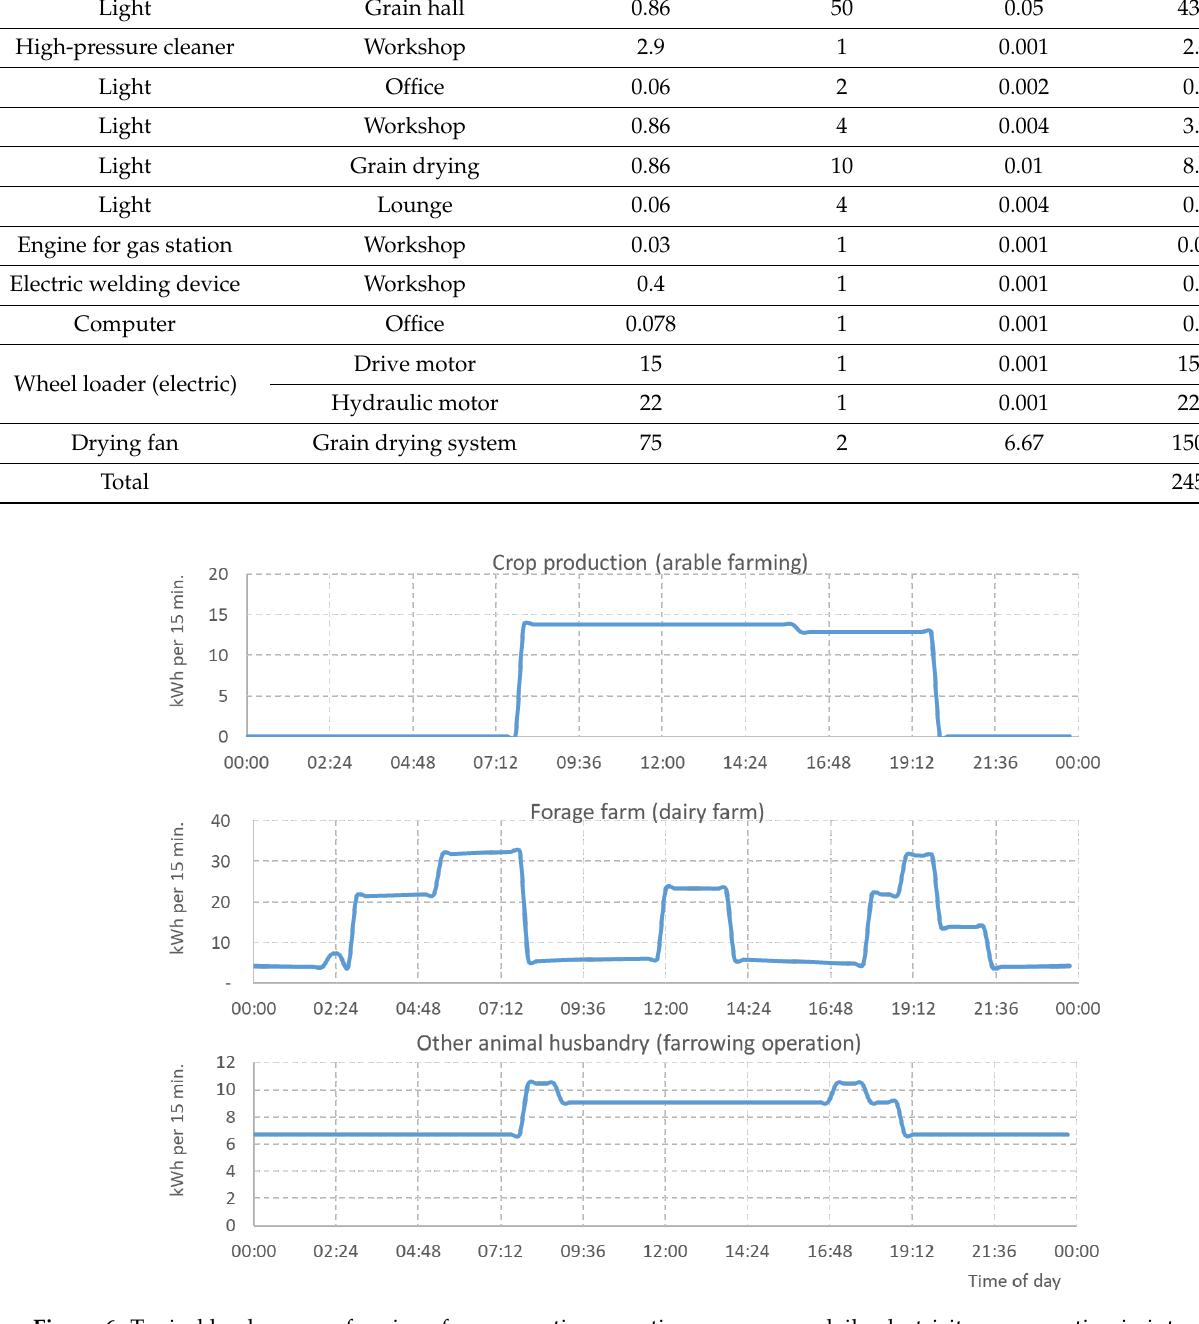
Table 4. Typical average daily electricity consumption of various farm operations: regular electricity consumption without variable additional power consumption for forage farm (dairy farm) and other animal husbandry (farrowing operation, piglet rearing, pig fattening, broiler fattening). Key Figure